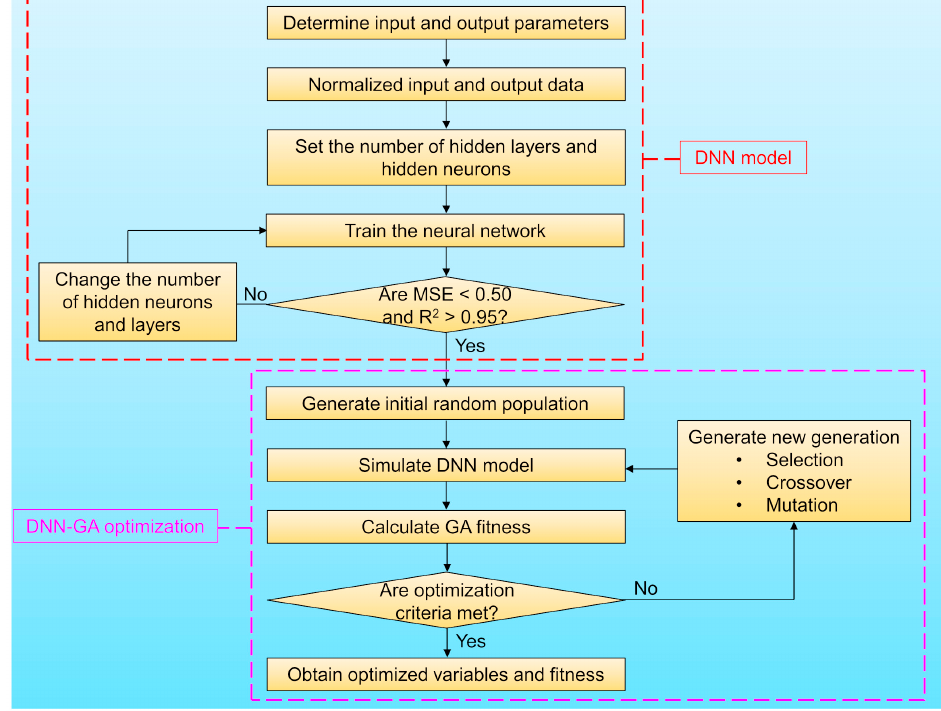
Figure 8. Algorithm for determination of optimal varying BHF based on the integration of DNN with genetic algorithm (GA).